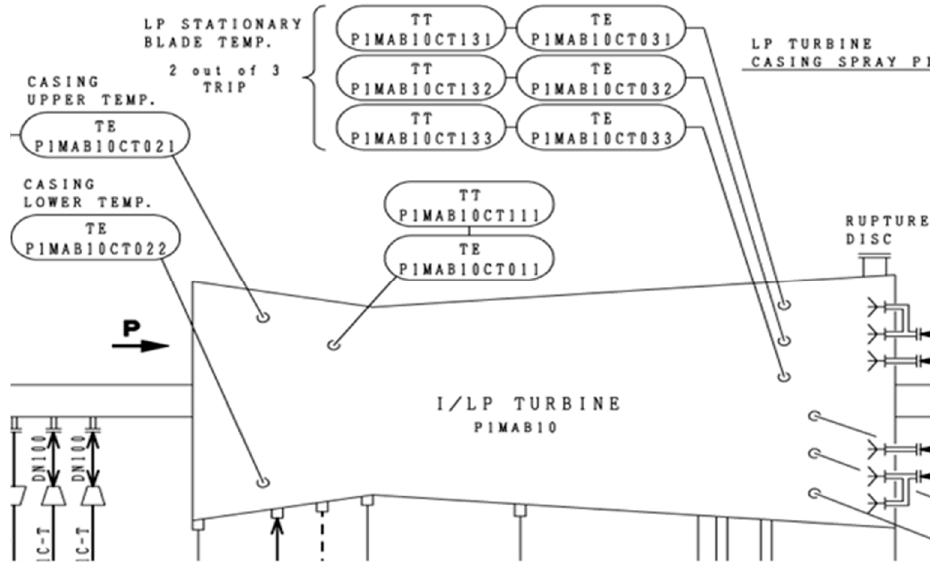
Figure 4. P&ID diagram of the LP turbine section in a TPP.